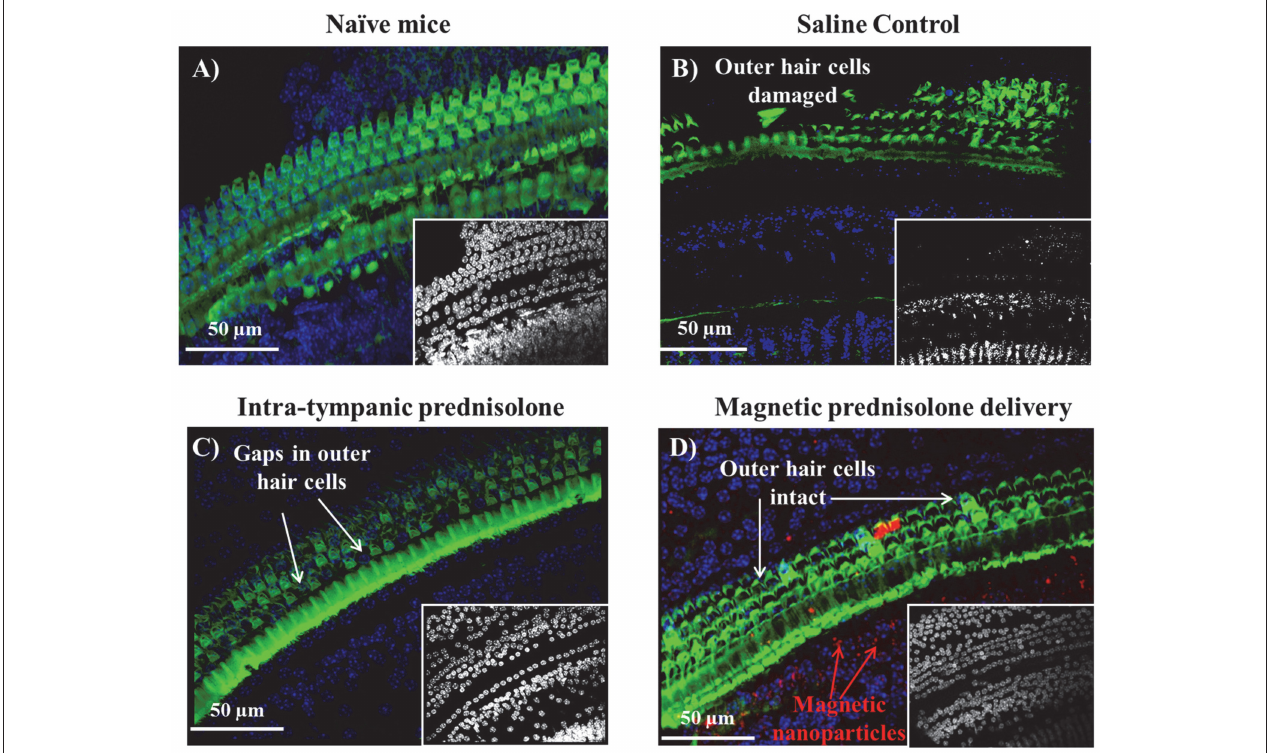
FIGURE 2 | Sample cytocochleograms of the basal cochlear region of different groups. The outer hair cells were stained for actin with Alexa Fluor 488 Phalloidin (green) and the various cell nuclei were stained using DAPI counterstain (blue). (A) Left ear from a naïve animal that did not receive any cisplatin treatment or otoprotection. For animals that were administered cisplatin: (B) Left ear that received saline; (C) Left ear that received intra-tympanic methyl-prednisolone; and (D) Left ear that received magnetic delivery of prednisolone. The images of the DAPI stained nuclei for all the groups have been shown in the image insets of (A–D) correspondingly. (A version of this figure has also appeared in an invited feature article in The Hearing Journal, July 2017 issue.)